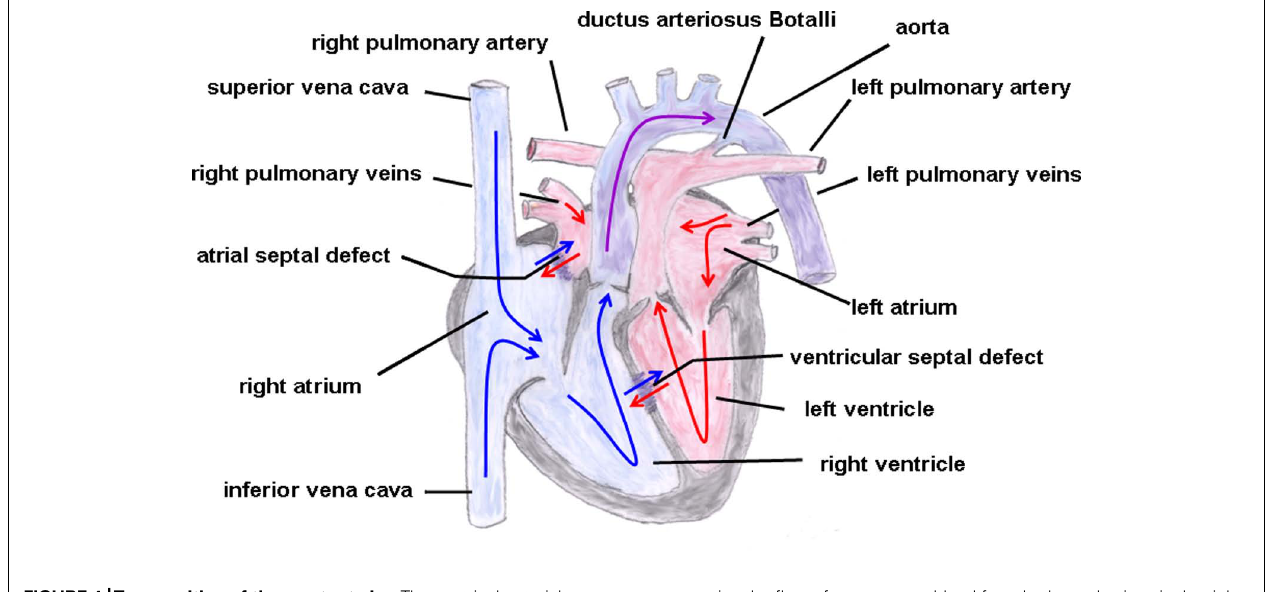
arrows give the flow of oxygen-poor blood from both caval veins via the right atrium and the right ventricle to the aorta.The red arrows give the flow of oxygen-rich blood from the pulmonary veins via the left atrium and the left ventricle to the pulmonary